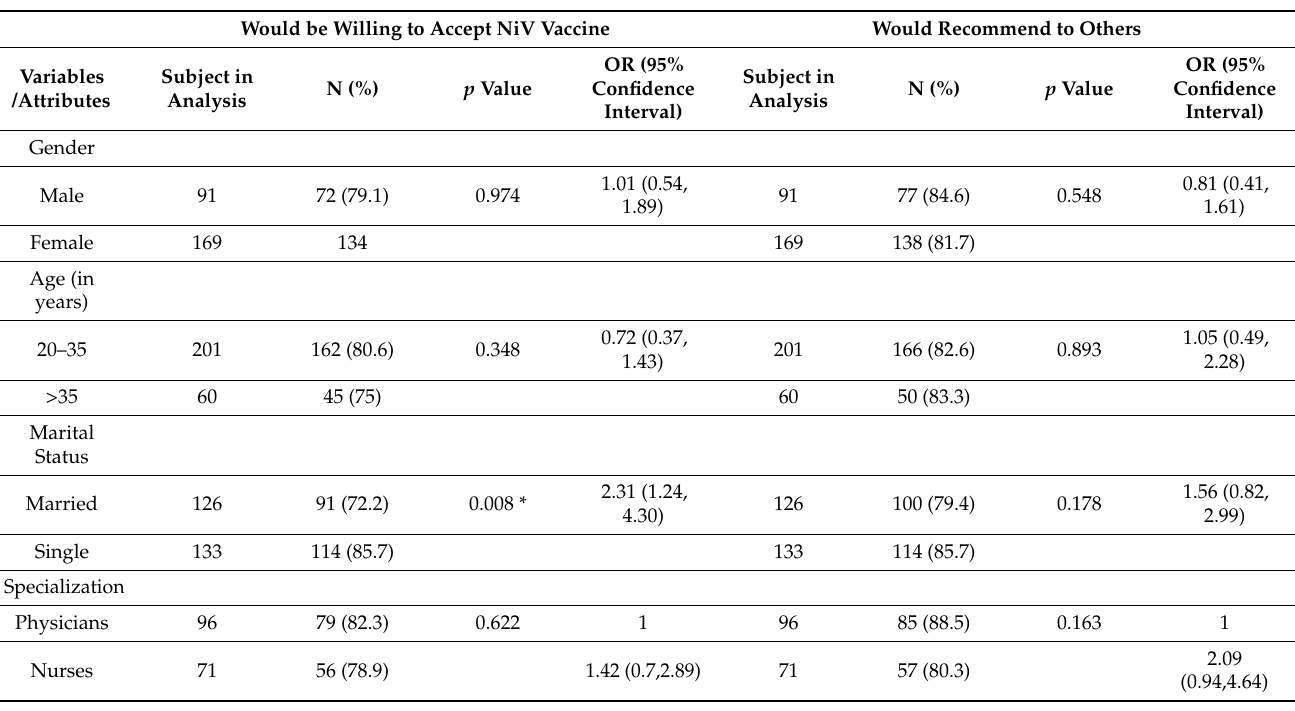
Table 11. Intention to receive a future NiV vaccine among Health Care Providers and Recommenda- tion of vaccine to others. Statistical test used was chi-squared test for independence of